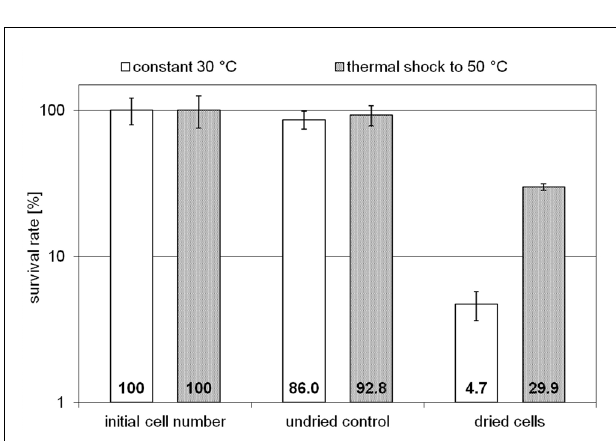
FIGURE 4 | Survival rates of unstressed H. elongata cells (initial cell number), undried control cells and cells which survived harsh drying for 3 h at 45 ◦ C and 10 mbar (error bars show standard deviations of